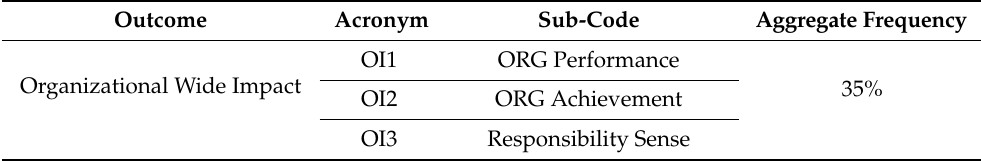
Table 2. Preliminary outcomes and their